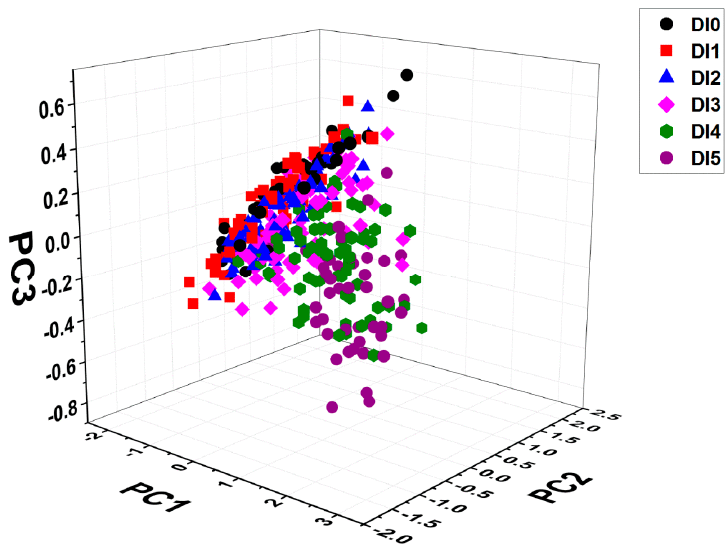
Figure 3. Scores’ scatter plots of samples in six degrees of infestation.